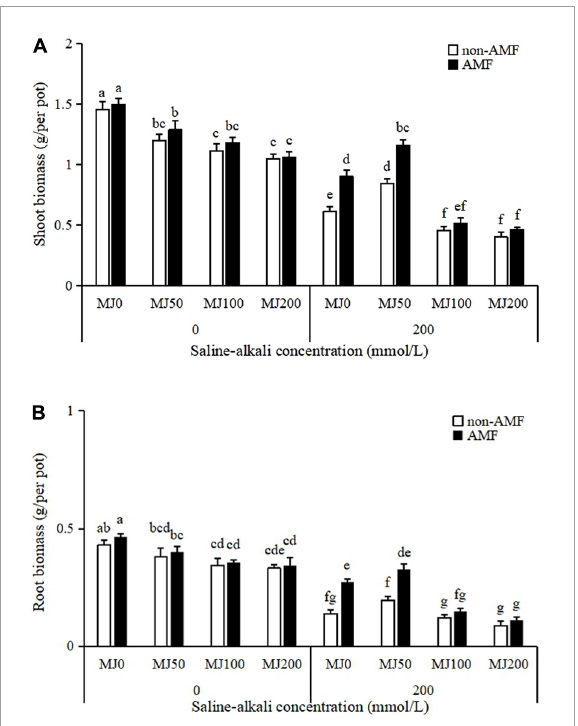
FIGURE3 Shoot (A) and root (B) biomass of tall fescue as effects by the interaction between arbuscular mycorrhizal fungi (AMF), different methyl jasmonate (MeJA) levels (0 MeJA = 0 mg/L, 50 MeJA = 50 mg/L, 100 MeJA = 100 mg/L, 200 MeJA = 200 mg/L) and saline-alkali stress. Different letters above the bars indicate significant differences according to Duncan’s multiple range test ( P ≤